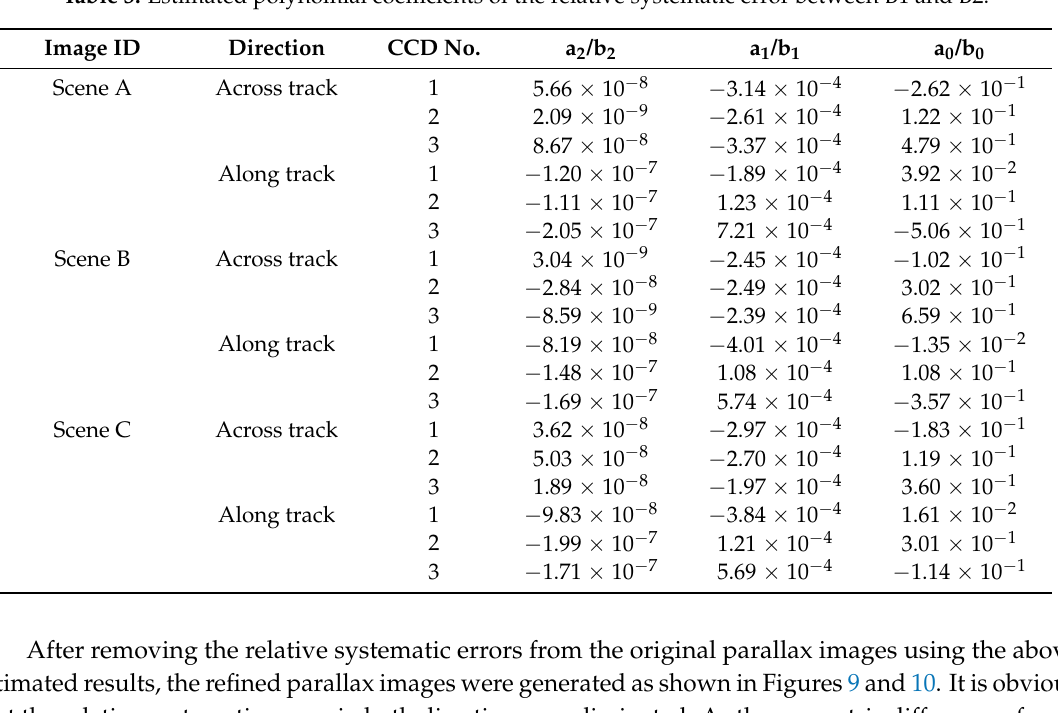
Table 3. Estimated polynomial coefficients of the relative systematic error between B1 and B2.